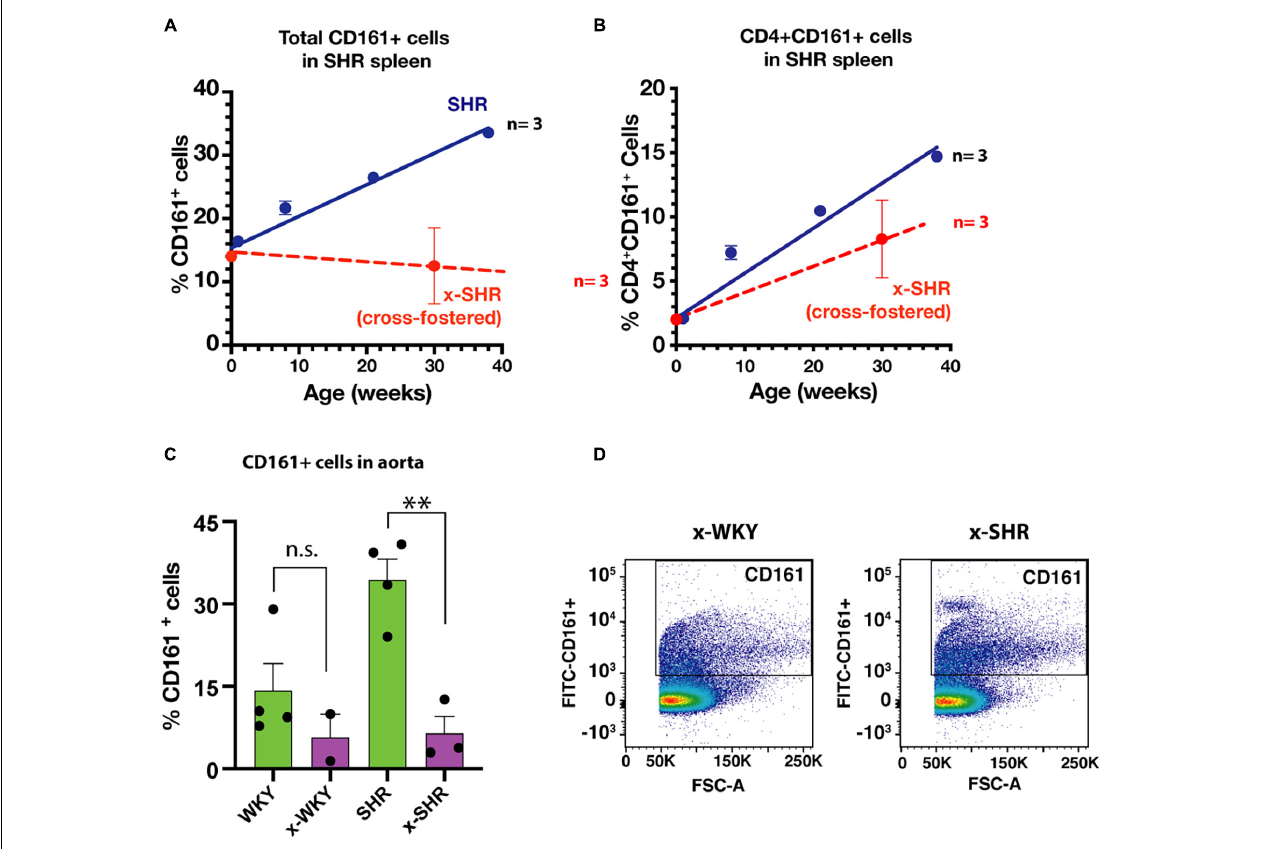
FIGURE 4 | (A) Cross-fostering of SHR prevents the age dependent increase in CD161 + cells and (B) CD4 + CD161 + cells observed in self-fostered SHR as previously reported (Singh et al., 2017) (Blue line). (C) Comparison of infiltration of proinflammatory CD161 + immune cells in aortic tissue in self-fostered cross-fostered WKY and SHR. (D) Representative dot plot of CD161 + cells in thoracic aorta of cross-fostered WKY (x-WKY) and cross-fostered SHR (x-SHR). Asterisks denote statistically significant ( ∗∗ P < 0.0075), whereas n.s. denotes statistically not significant results by one-way ANOVA and Sidak’s post hoc test.